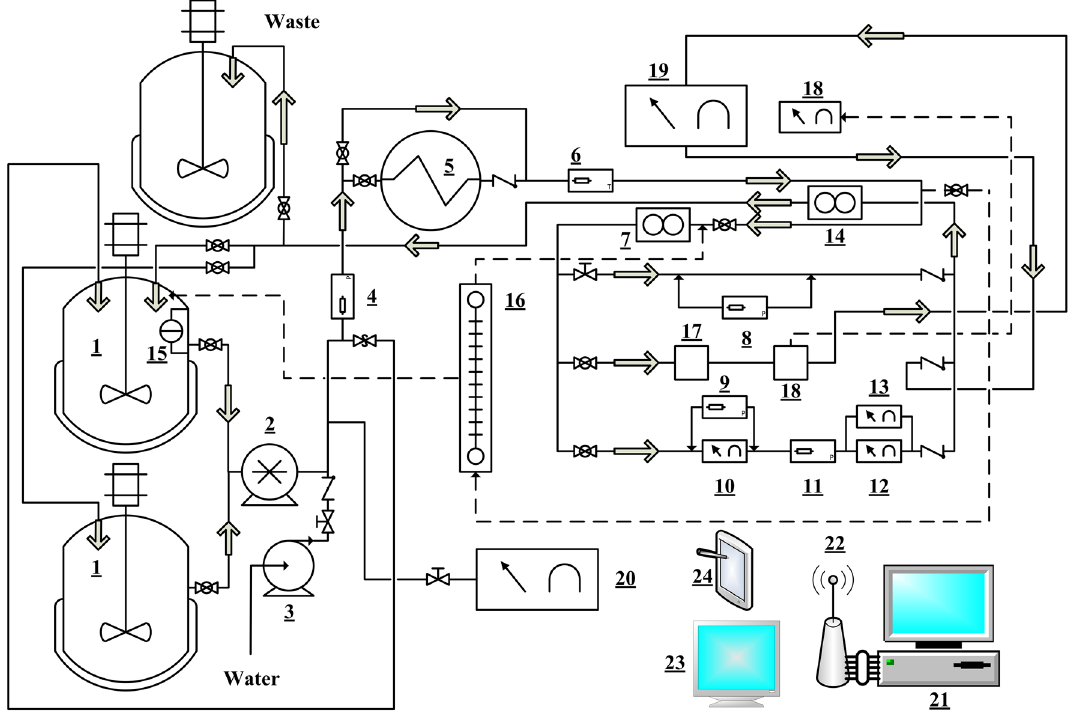
Fig. 1 Simplified schematic of the drilling fluid flow loop. 1—Stirred tanks, 2—main pump, 3—auxiliary pump, 4—pressure gauge, 5— heat exchanger, 6—thermocouple, 7—flow meter, 8—tubular visco- simeter, 9—pressure drop sensor, 10—coaxial cylinders viscosim- eter, 12—electrical conductivity meter, 13—electrical stability